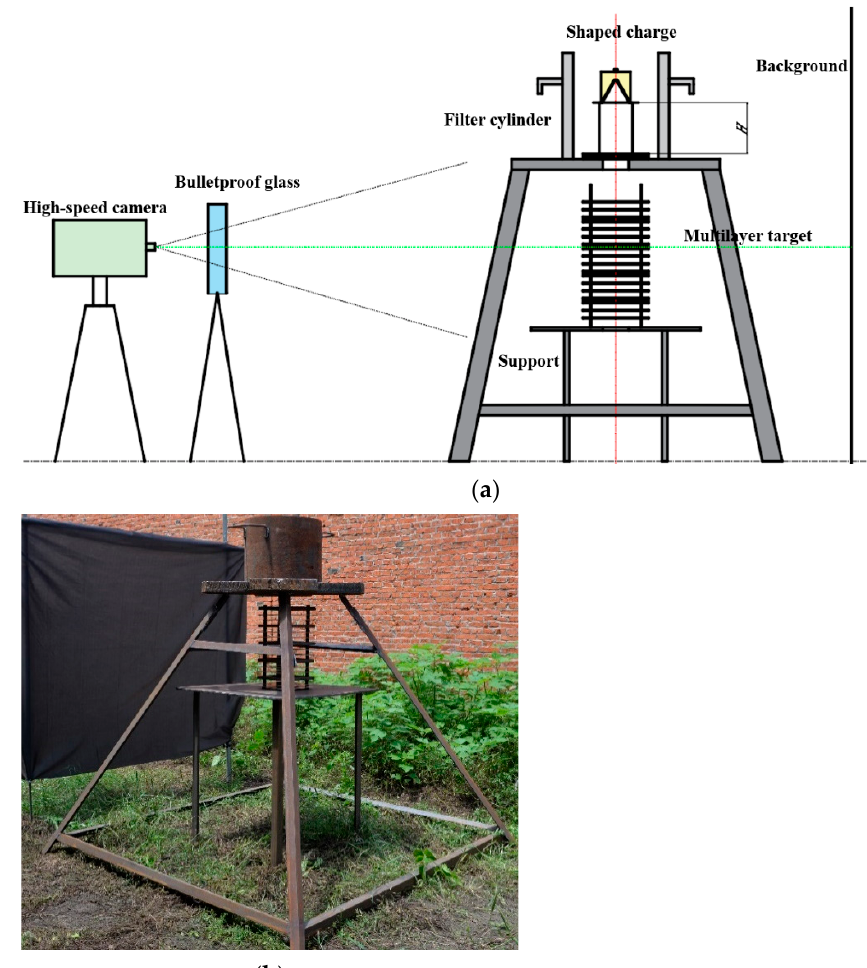
Figure 6. Setup of the penetration experiment: ( a ) schematic; ( b ) photo.